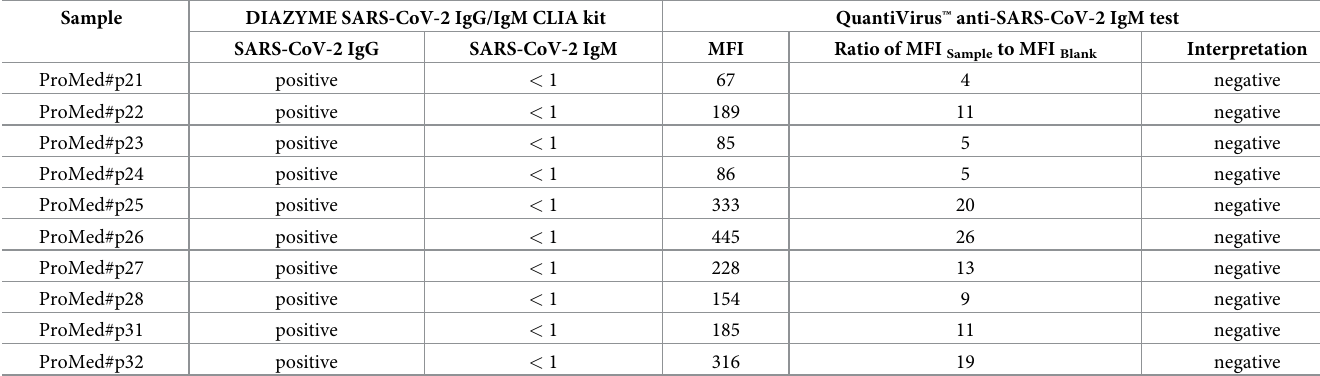
Table 6. Class-specificity